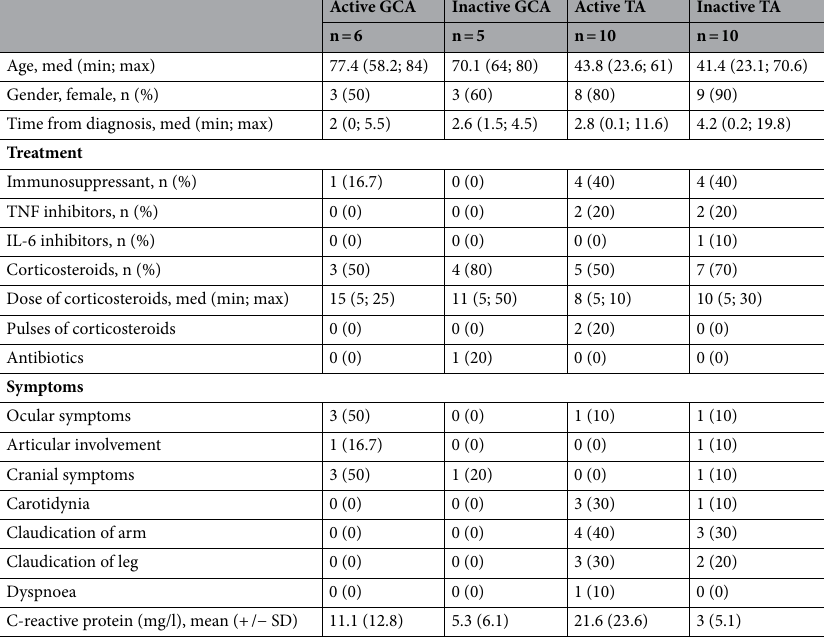
Table 1. Patient